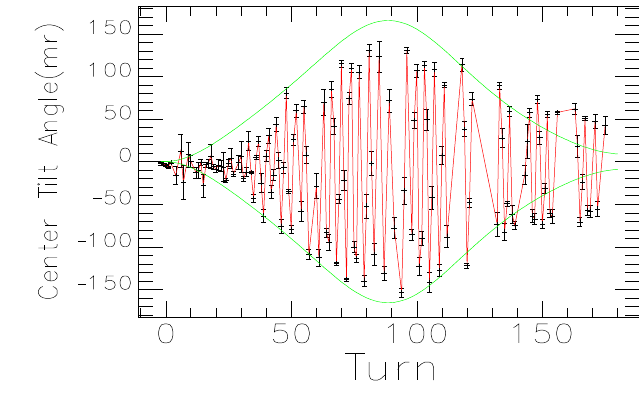
FIG. 5. (Color) The center angle changes with time. FIG. 3. (Color) The sinusoidal fit to the bunch slice centroid of (cid:6) A sin (cid:4) !t (cid:6) (cid:10) (cid:5) , ! (cid:3) y 0 (cid:3) 1 : 19 mm and (cid:10) (cid:3) y (cid:3) y; cal